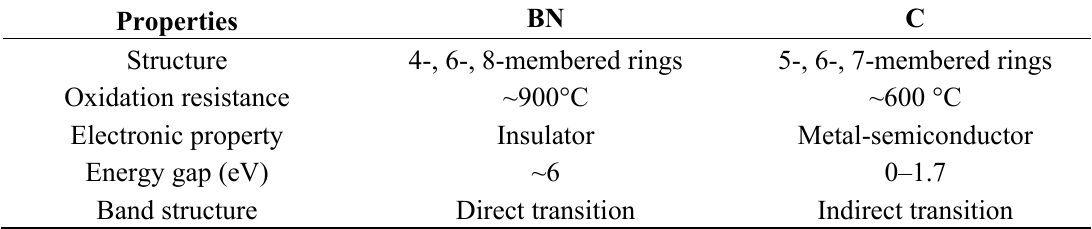
Table 1. Differences between boron nitride (BN) and C